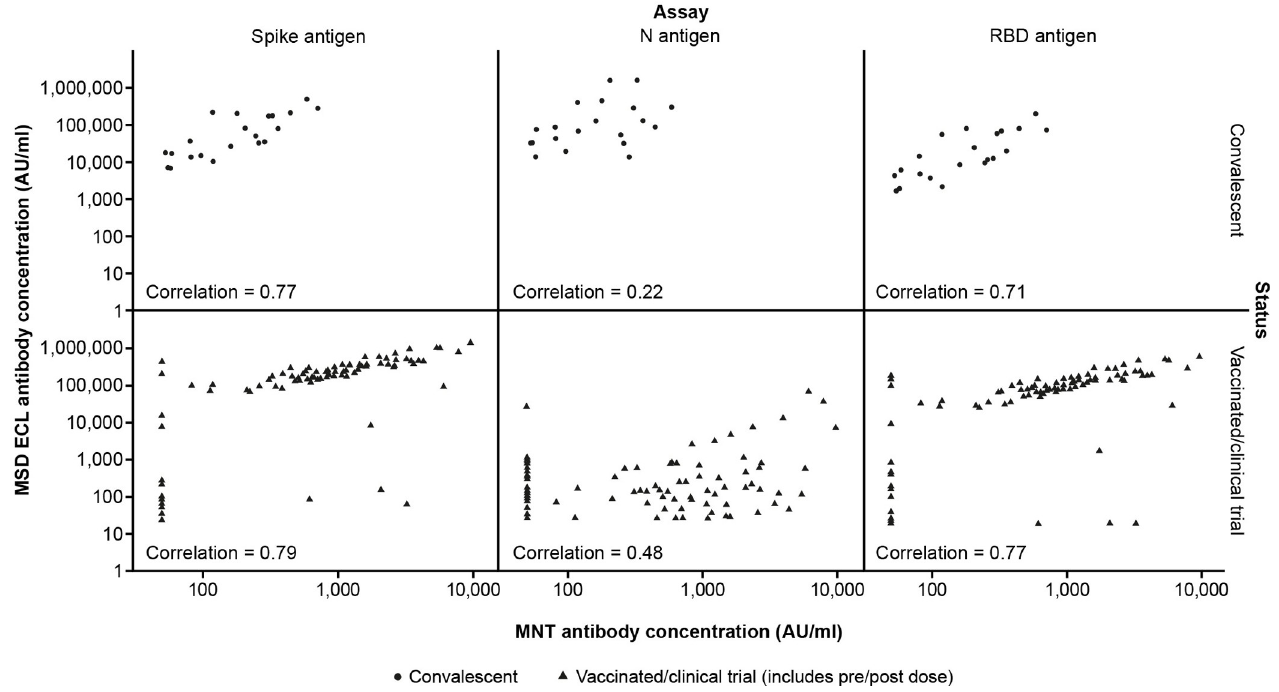
Fig 5. Correlation between MNT and MSD ECL assays in convalescent and vaccinated human samples. Comparison of assay results for convalescent sera samples (n = 32) and sera samples from vaccinated individuals (n = 52) from individuals who received one or two doses of mRNA-1273 or BNT162b2, and 30 pairs [Days 1 and 28 post-vaccination] from individuals vaccinated in a Moderna clinical trial) [8] using the microneutralization assay and in the multiplex ECL assay for detection IgG antibodies against SARS-CoV-2 spike, nucleocapsid, and receptor-binding domain antigens. ECL = electrochemiluminescence; IgG = immunoglobulin G; MNT = microneutralization assay; MSD ECL antibody concentration = antibody concentration as determined in the MSD multiplex electrochemiluminescence assay; N antigen = SARS-CoV-2 nucleocapsid protein antigen; RBD antigen = SARS-CoV-2 receptor-binding domain protein antigen; Spike antigen = SARS-CoV-2 spike protein antigen; SARS-CoV-2 = severe acute respiratory syndrome coronavirus 2.